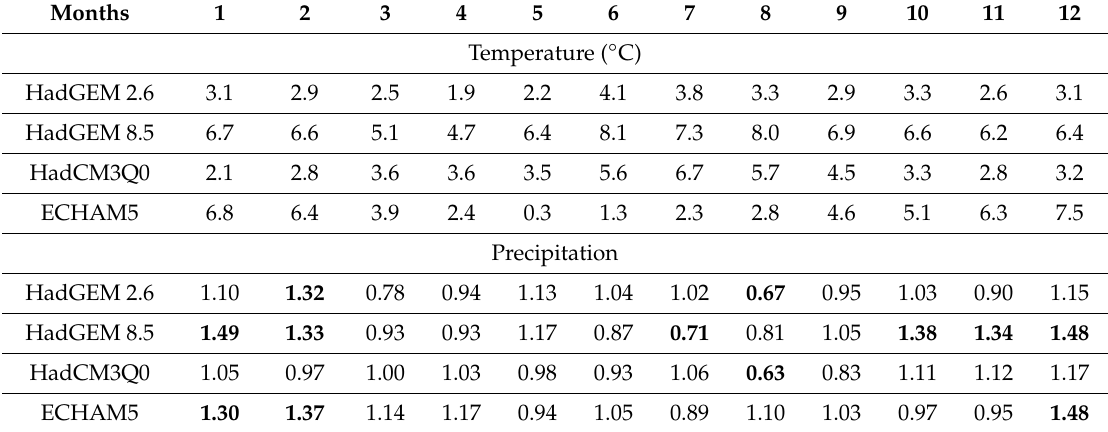
Figure 7. Precipitation scenarios for the study region. Note that neither model projects significant changes in precipitation in spring–early summer when precipitation maximum is observed. A shifts in seasonal maximum towards spring is projected under the HadGEM8.5 scenario. Table 3. Projected changes in monthly air temperature and precipitation in 2076–2095 in comparison with the baseline period (1985 / 1986–2004 / 2005). Absolute changes are shown for temperature and relative for precipitation. Changes in precipitation significant at 5% confidence level are highlighted in